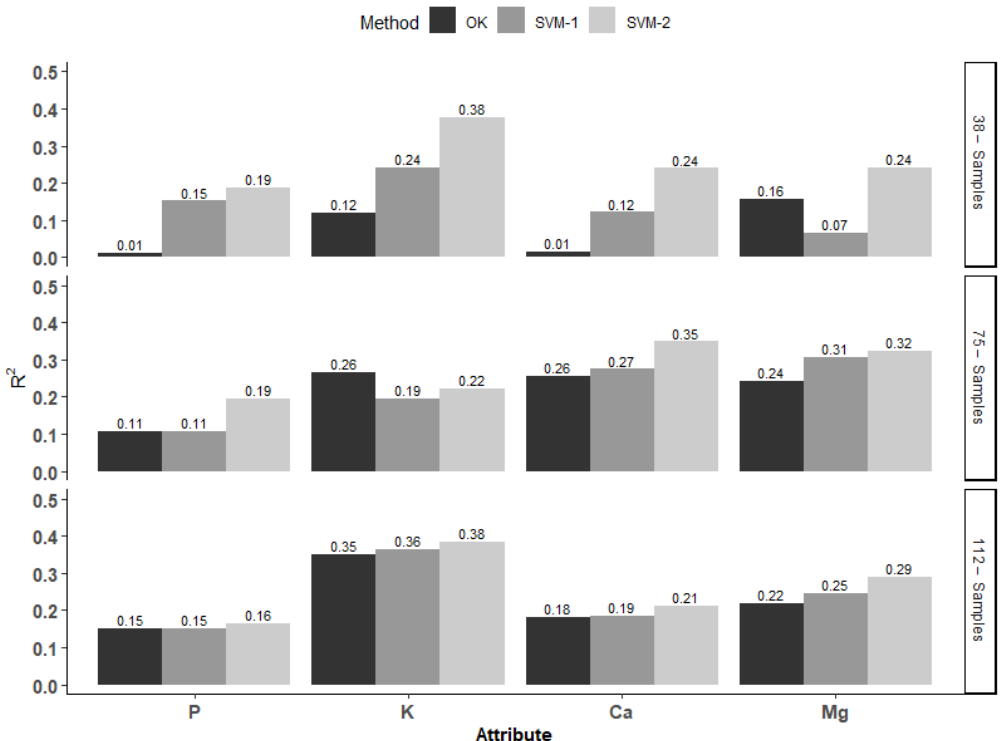
Figure 7. Coefficient of Determination (R 2 ) calculated for the attributes P, K + , Ca 2+ , and Mg 2+ among three sampling grids for the training set.